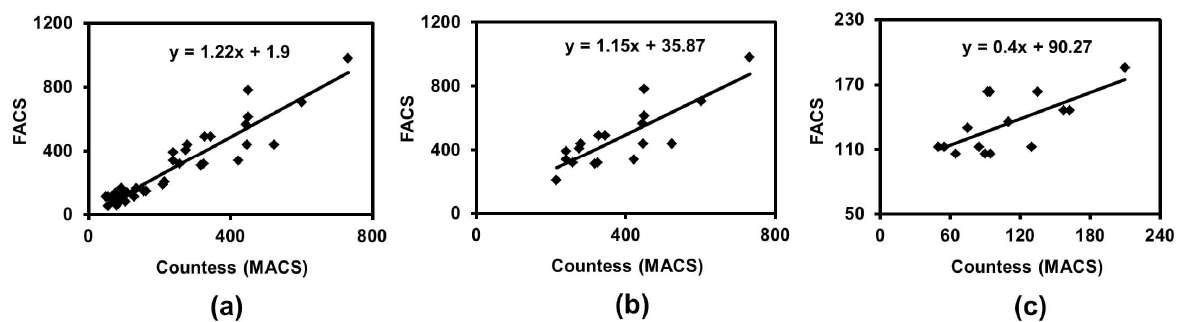
Figure 3. Linear regressions of CD4 + T cell counts using an optimized MACS procedure (50 µ L blood, 25 µ L NP-CD4) ( x axis) against the counts obtained using FACS ( y axis). Linear regressions generated from ( a ) a total of 38 samples, ( b ) 18 samples in groups I and II with CD4 + T counts > 200 cells/µL, and ( c ) 15 samples in group III with CD4 + T counts of 200–100 cells/µL. The plots are represented as the number of CD4 + T cells per microliter of blood. Table 1. Results of CD4 + T cell counts acquired using MACS-Countess and biases of MACS-Countess compared with FACS. Group (CD4 + T Cells/ µ